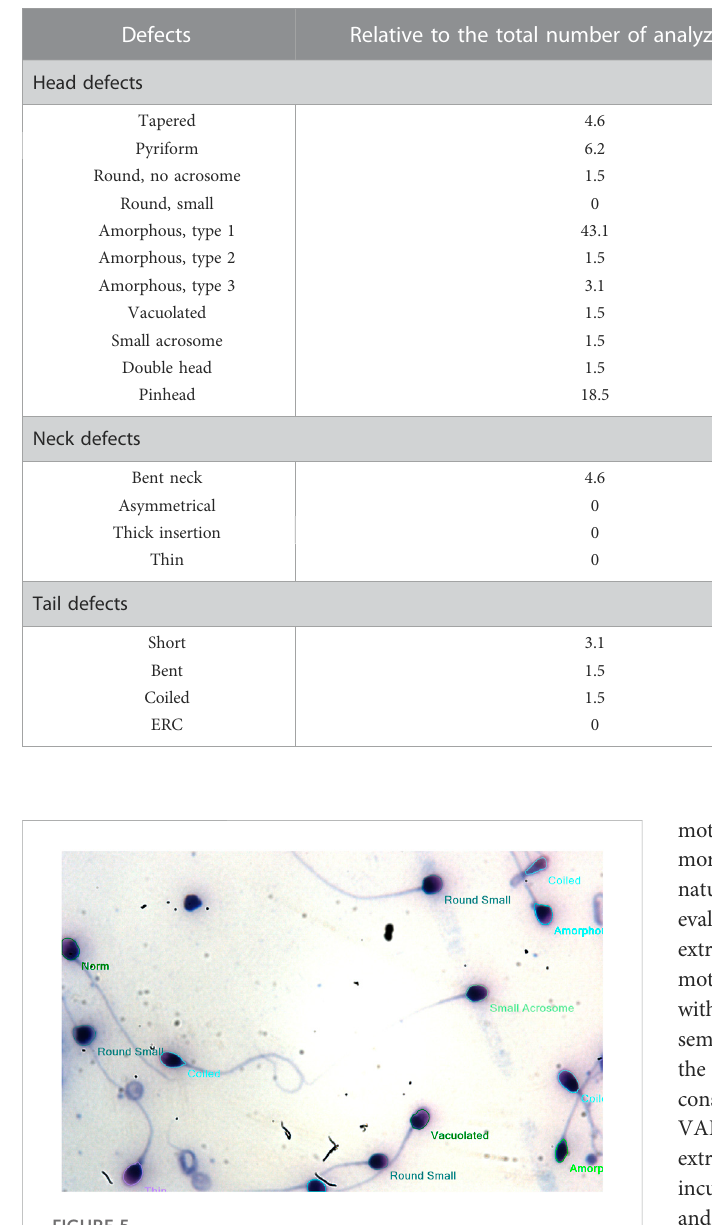
TABLE 3 Sperm vitality parameters after 10 min incubation with 100 μ g/ml of AMLE.